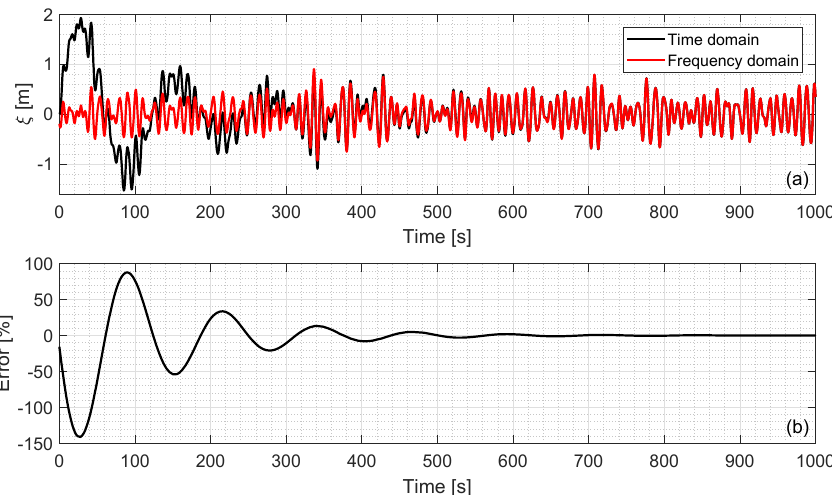
Figure 2. (a) Surge response of the OC3-Hywind floating wind turbine (Jonkman, 2010) to stochastic hydrodynamic linear forcing in a one- DoF linear model, computed in both the time and frequency domains. (b) Relative error between the time- and frequency-domain solutions. Only the first 1000s are shown. Table 1. Key figures for the DTU 10 MW RWT. Rated power Rated wind speed Wind regime Rotor diameter Hub height 10MW 11.4ms − 1 IEC Class 1A 178.3m